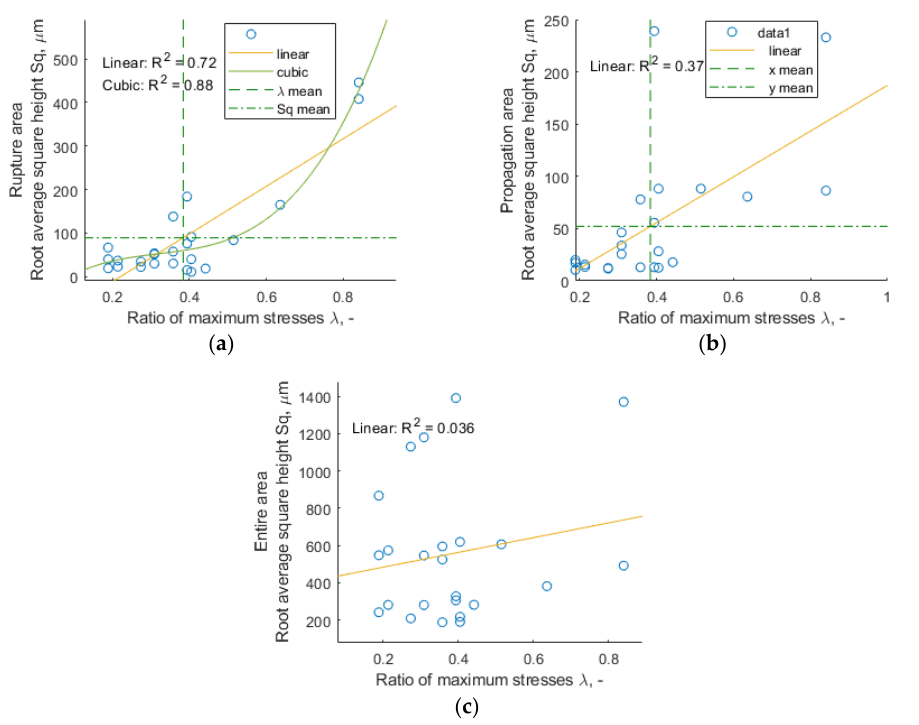
Figure 8. Areal surface parameter Sq evaluation at different applied ratio of maximum stresses λ for the investigated zones: ( a ) rupture area; ( b ) propagation area; ( c ) entire area.